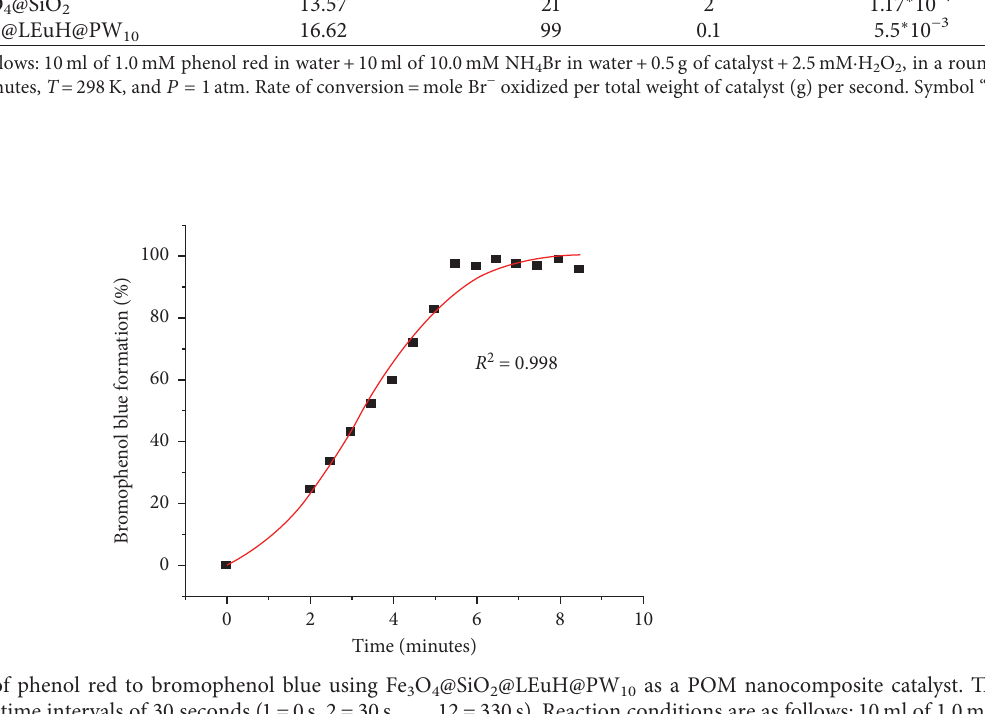
Table 2: Catalytic bromination activities of LEuH-Cl, Fe